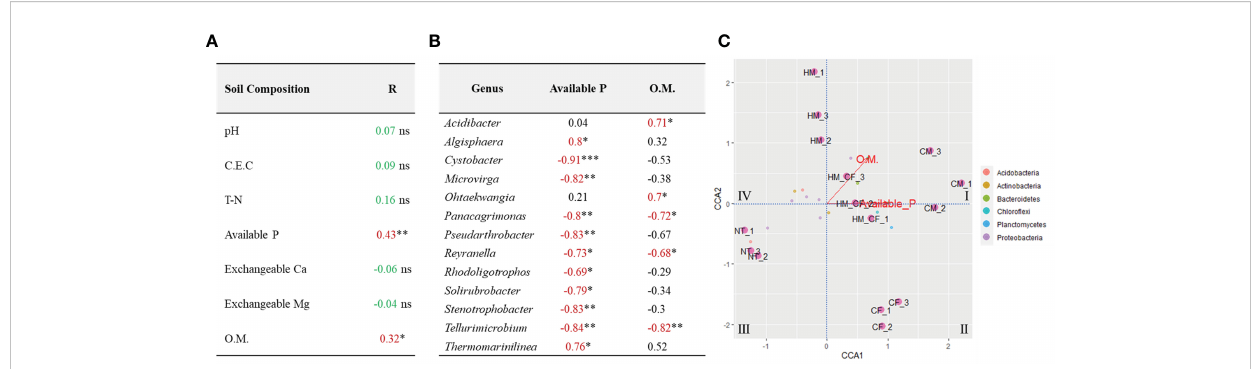
FIGURE 5 Correlation analysis between soil properties and bacterial community structures in the soils after different fertilizer supplies (NT, non-treatment; CM, commercial manure; HM, Hanwoo manure; CF, chemical fertilizer; HM+CF, combined use of Hanwoo manure and chemical fertilizer). (A) Mantel test between soil properties on bacterial community composition. Signi fi cant results are indicated by *P < 0.05 and **P < 0.01 (NS = no signi fi cance). (B) Signi fi cant correlation between two chemical components and soil bacteria. The signi fi cance was measured by using the n-2 degrees of freedom (*P < 0.05, **P < 0.01, and ***P < 0.001). (C) Canonical correspondence analysis of bacterial community composition and soil properties in soils after different fertilizer